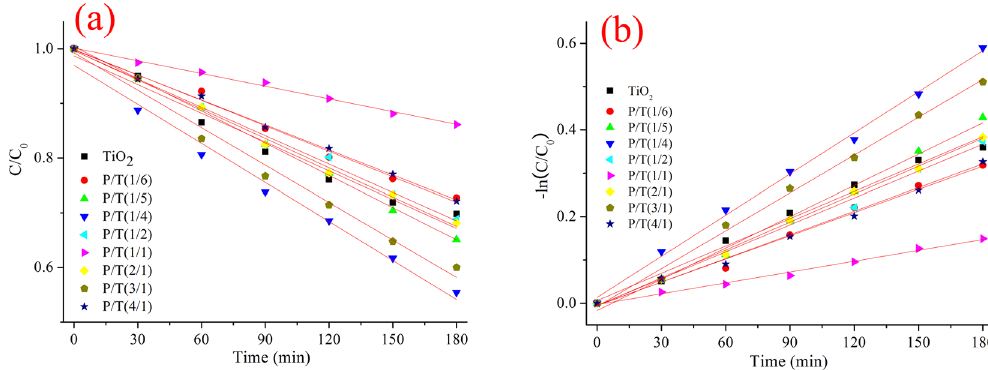
Figure 8. ( a ) The decolorization ratio of MB and ( b ) the apparent first-order linear transforms in the presence of